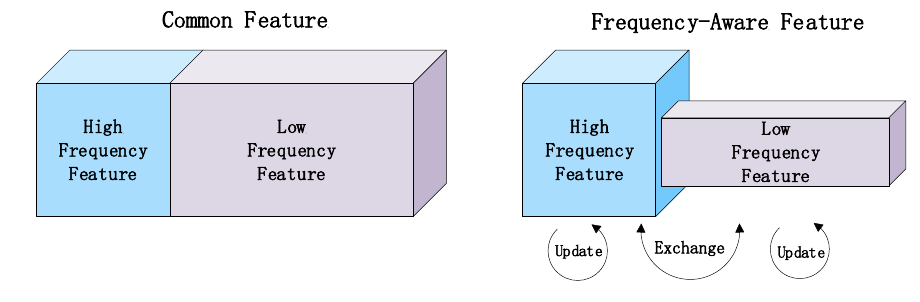
Figure 3. Frequency-aware